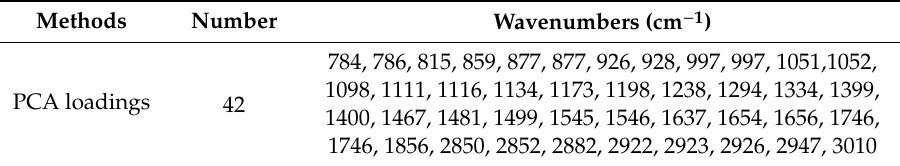
Figure 2. Optimal wavenumbers selected by loadings of PC1, PC2 and PC3. Figure 3. Optimal wavenumbers selected by loadings of PC1, PC2 and PC3. Table 3. Optimal wavenumbers selected by PCA